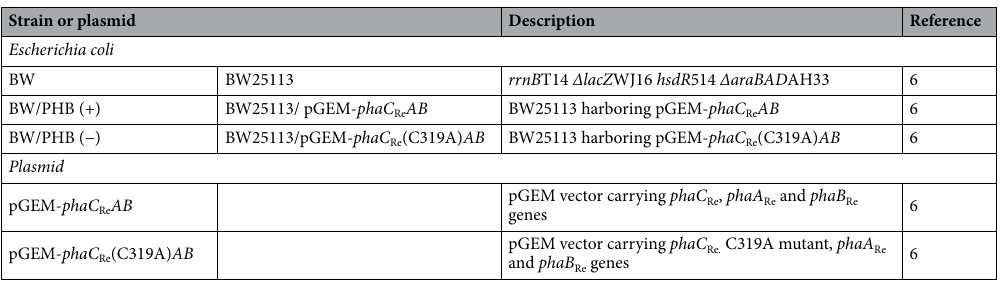
Table 2. Escherichia coli strain and plasmid used in this